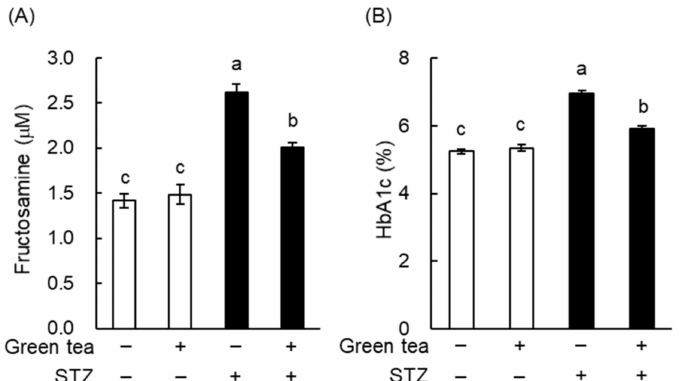
Figure 3. Green tea consumption reduced plasma fructosamine and glycated hemoglobin (HbA1c) concentrations in STZ-induced T1DM rats. Rats were treated as described in Figure 1A. ( A ) Plasma fructosamine was measured using the nitro blue tetrazolium (NBT) colorimetric method, as described in “Materials and Methods”. ( B ) Plasma HbA1c was measured using a commercial test kit. Data are expressed as the means ± SE ( n = 5). Values sharing the same letters were not significantly di ff erent (Tukey-Kramer multiple comparison test; p <